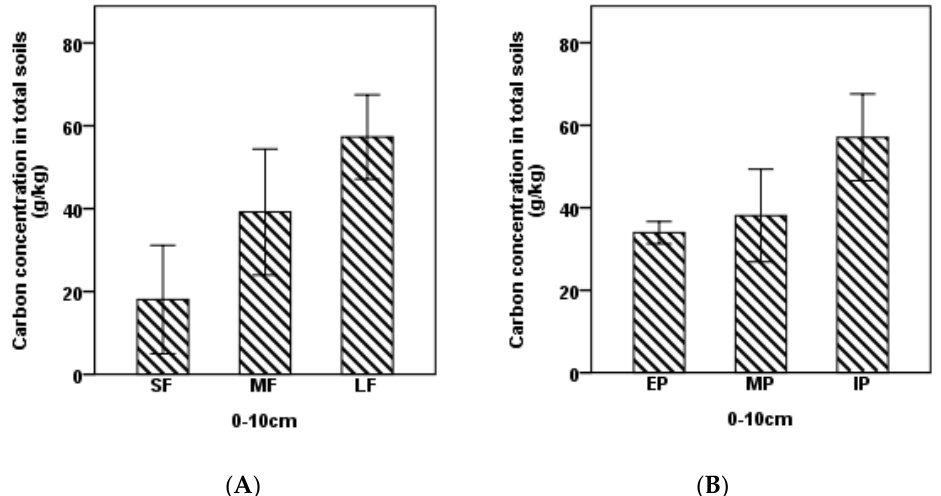
Figure 3. Soil carbon concentration in soils (g/kg) among different type of plots: ( A ) soil carbon concentration in soils (g/kg) among different forest fragments with different patch size; ( B ) soil carbon concentration in soils (g/kg) from forest edges to interiors.